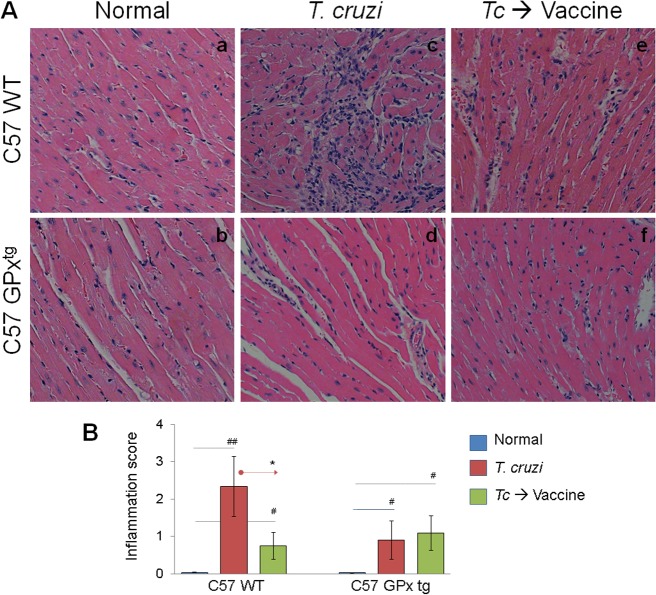
Myocardial inflammatory infiltrate in GPxtg and WT mice during chronic Chagas disease (± therapeutic vaccine).Mice (GPxtg and WT) were infected, vaccinated, and harvested during chronic disease phase as in Fig 1. (A) Paraffin-embedded left ventricular (LV) heart sections (5 μm) were examined by hematoxylin/eosin (H&E) staining (blue: nuclear; pink: muscle/cytoplasm). Shown are representative H&E images of tissue sections from normal (a&b), infected (c&d), and infected/vaccinated (e&f) mice harvested during chronic disease phase (>150 days post-infection, magnification: 20X). (B) The inflammatory score (myocarditis) were derived from two different experiments (n = 4 mice per group per experiment) as described in the Materials and Methods section.